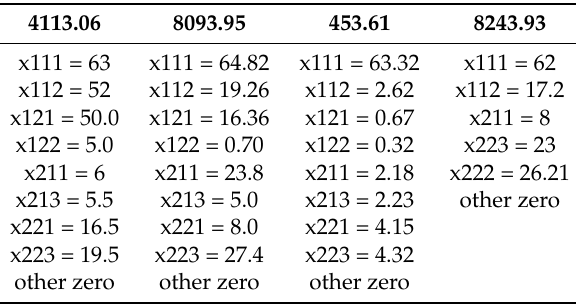
Table 11. Optimum solutions for 2D-TP Model.